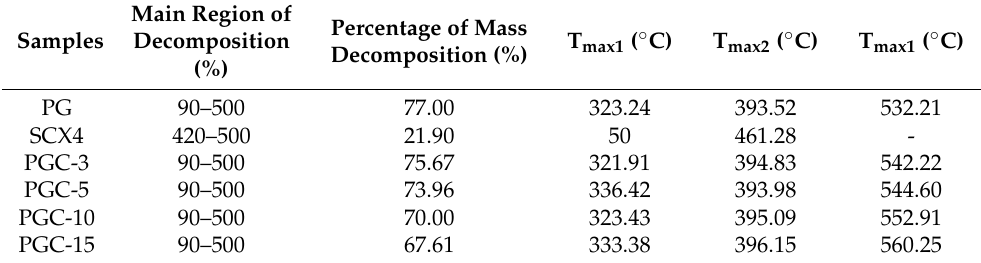
Table 1. TGA results of PG, SCX4, and